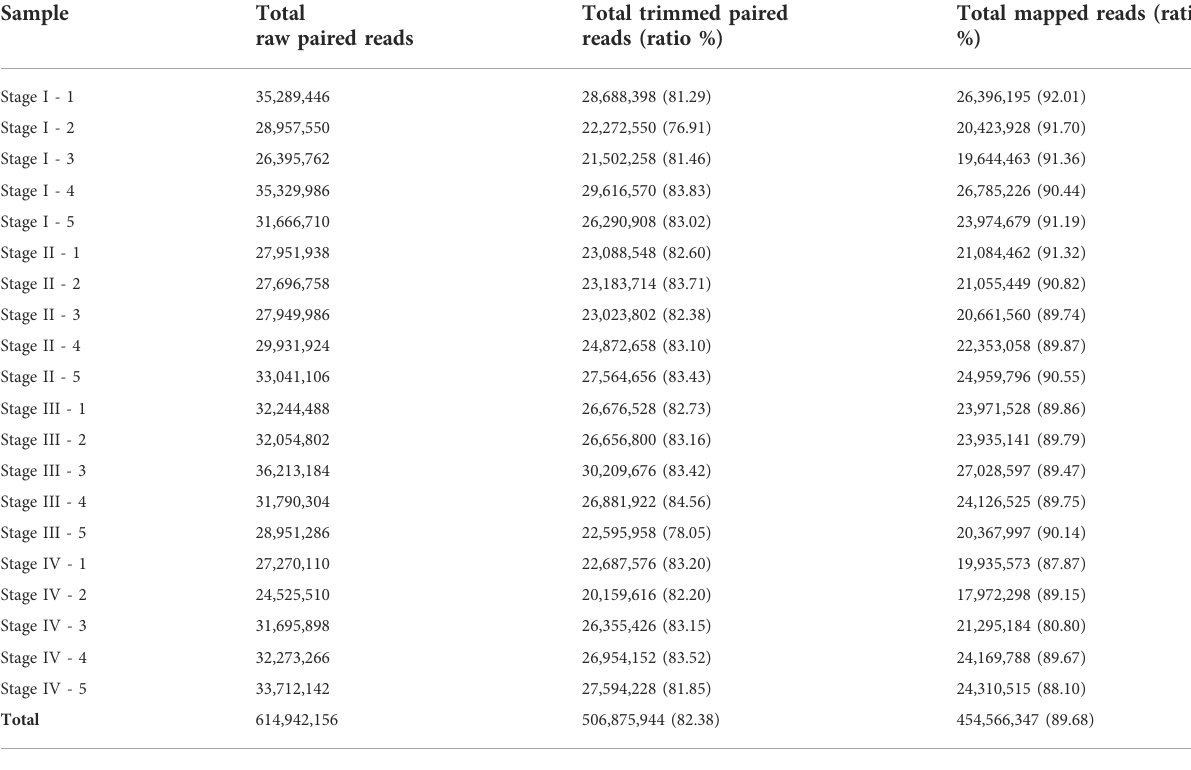
TABLE 1 Overview of RNA-Seq reads and mapping back to the assembled transcriptome.